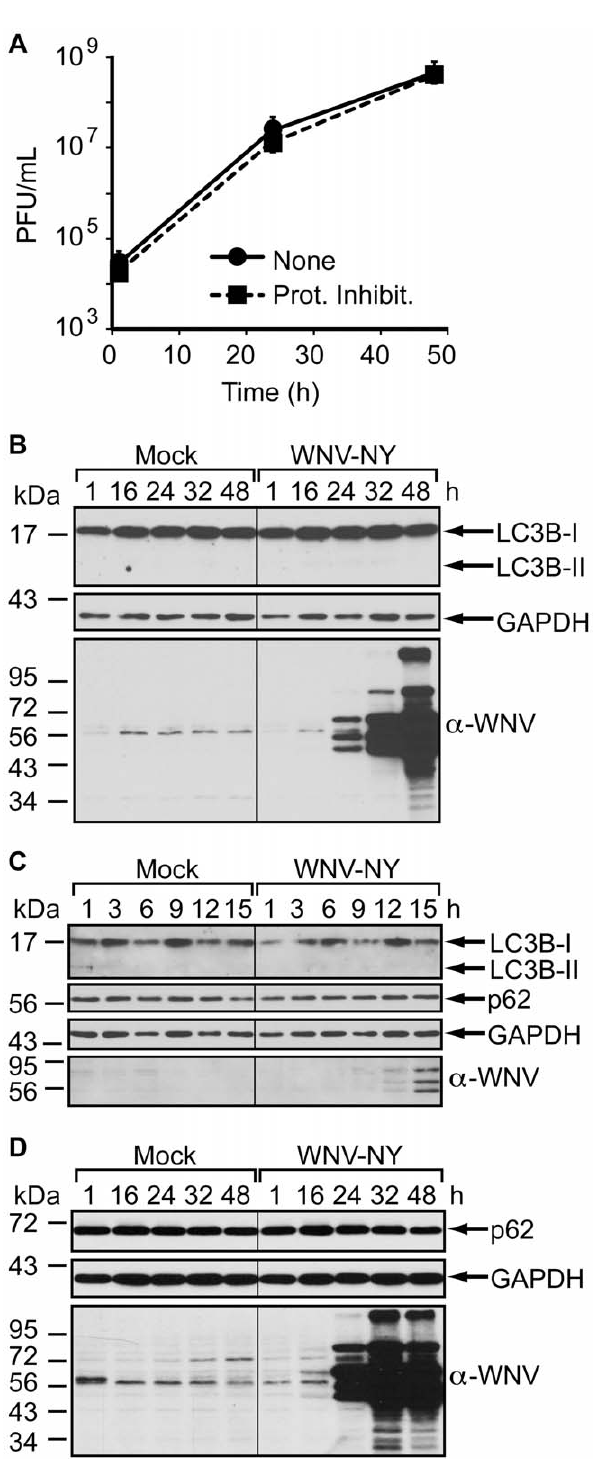
Figure 3. WNV-NY replication does not induce autophagy in 293T cells. (A) Effect of protease inhibitors on WNV replication. 293T cells infected with WNV-NY (MOI=3) were incubated in the presence (Prot. Inhibit.) or absence (None) of 10 m g/mL Pepstatin A and E64d. Media was removed from cultures at the indicated times, cleared of cell debris, and titers determined by plaque assay on Vero cells. Values represent the average ( 6 standard error) number of plaque-forming units (pfu) per mL from two independent experiments. (B) Effect of WNV-NY infection on steady-state levels of LC3B-II. 293T